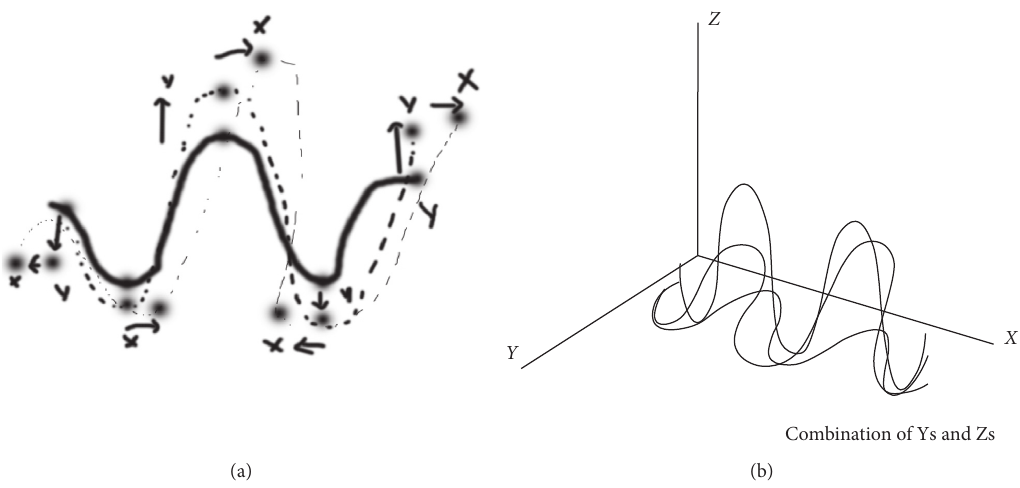
Figure 11: Curve on the combination of y and z planes (source: drawing by the research